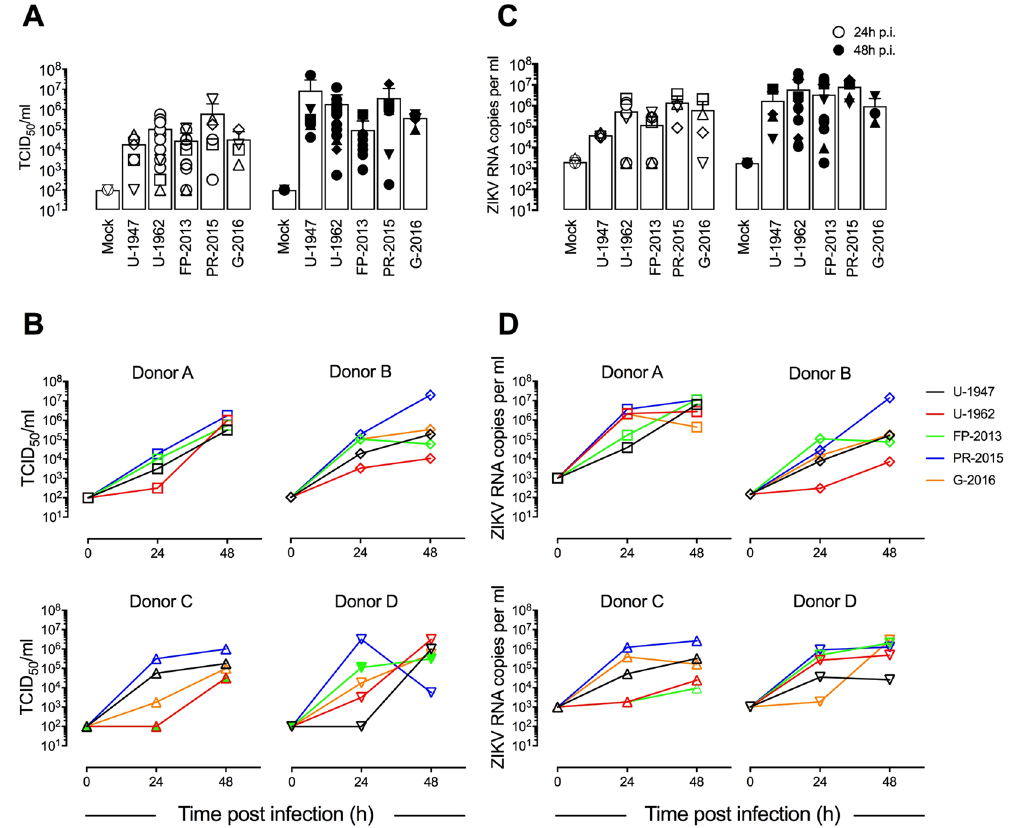
Figure 3. Replication of ZIKV in human MoDCs. ( A ) Measurement by TCID 50 assay of infectious ZIKV release in supernatants of MoDC cultures 24, and 48 h p.i. with five ZIKV strains at a MOI of 0.1 TCID 50 /cell. Data are presented as mean + / − SD of DCs generated from 4–12 independent blood donors. Individual donors are represented with a symbol: square (Donor A), diamond (Donor B), triangle (Donor C), inverted triangle (Donor D). ( B ) Single donor-dependent variation in infectious ZIKV release in supernatants of MoDC cultures 24, and 48 h p.i. with five ZIKV strains at a MOI of 0.1 TCID 50 /cell. ( C ) Measurement of extracellular viral RNA copies by quantitative RT-PCR in MoDC culture supernatants 24, and 48 h p.i. with five ZIKV strains at a MOI of 0.1 TCID 50 /cell. Data are presented as mean + / − SD of DCs generated from 4–12 independent blood donors. ( D ) Single donor-dependent variation of extracellular viral RNA copies by quantitative RT-PCR in MoDC cultures 24, and 48 h p.i. with five ZIKV strains at a MOI of 0.1 TCID 50